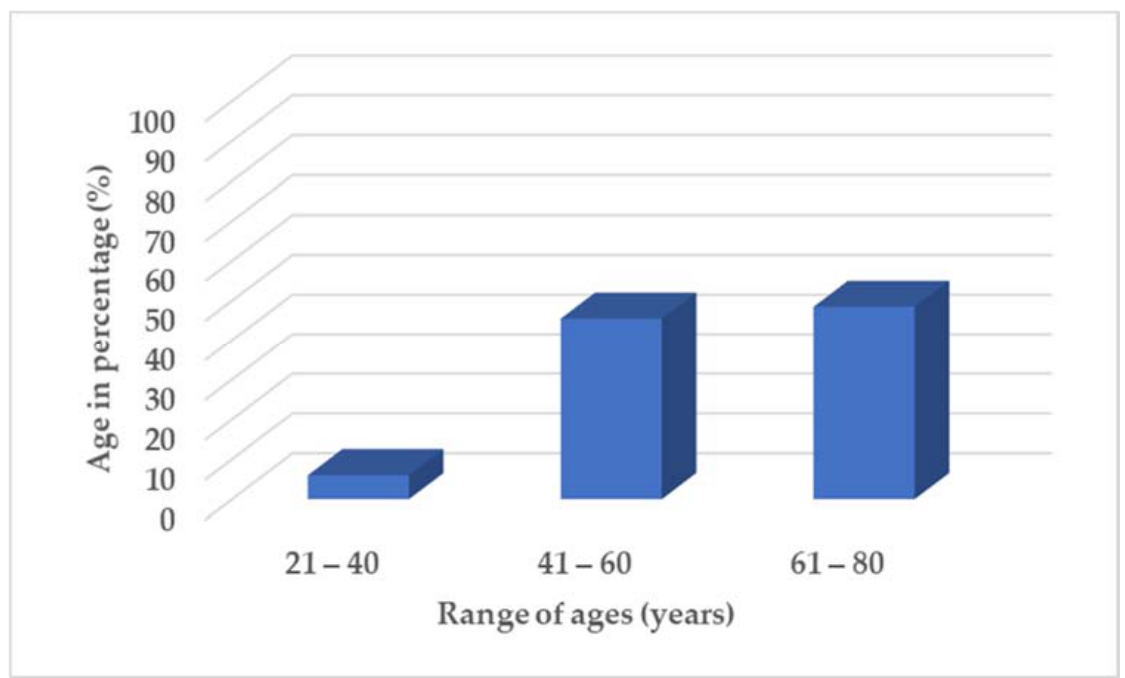
Figure 1. Age range in percentage (%) of knowledge holders participated in survey.